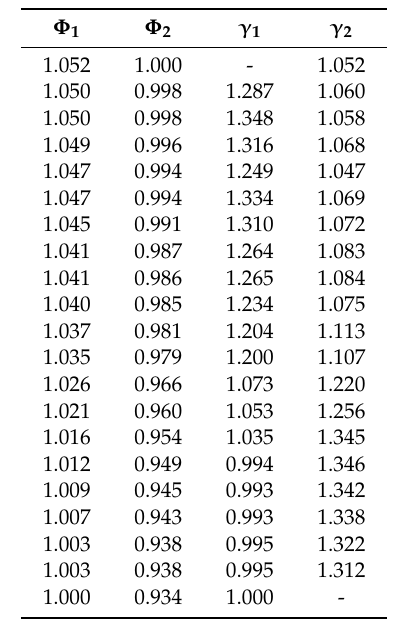
Table 3. Estimation of fugacity and activity coe ffi cient for acetone–butanol